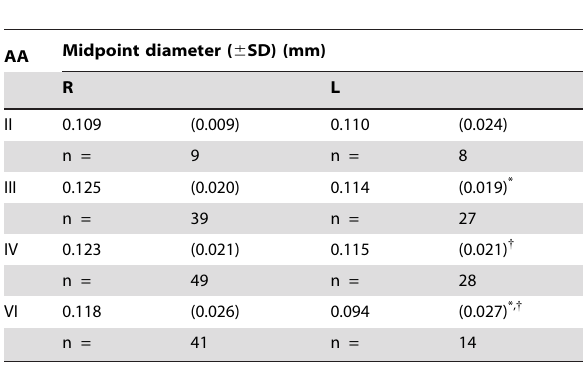
Table 1. Average AA midpoint diameter ( 6 SD) for all four possible AA present at stage